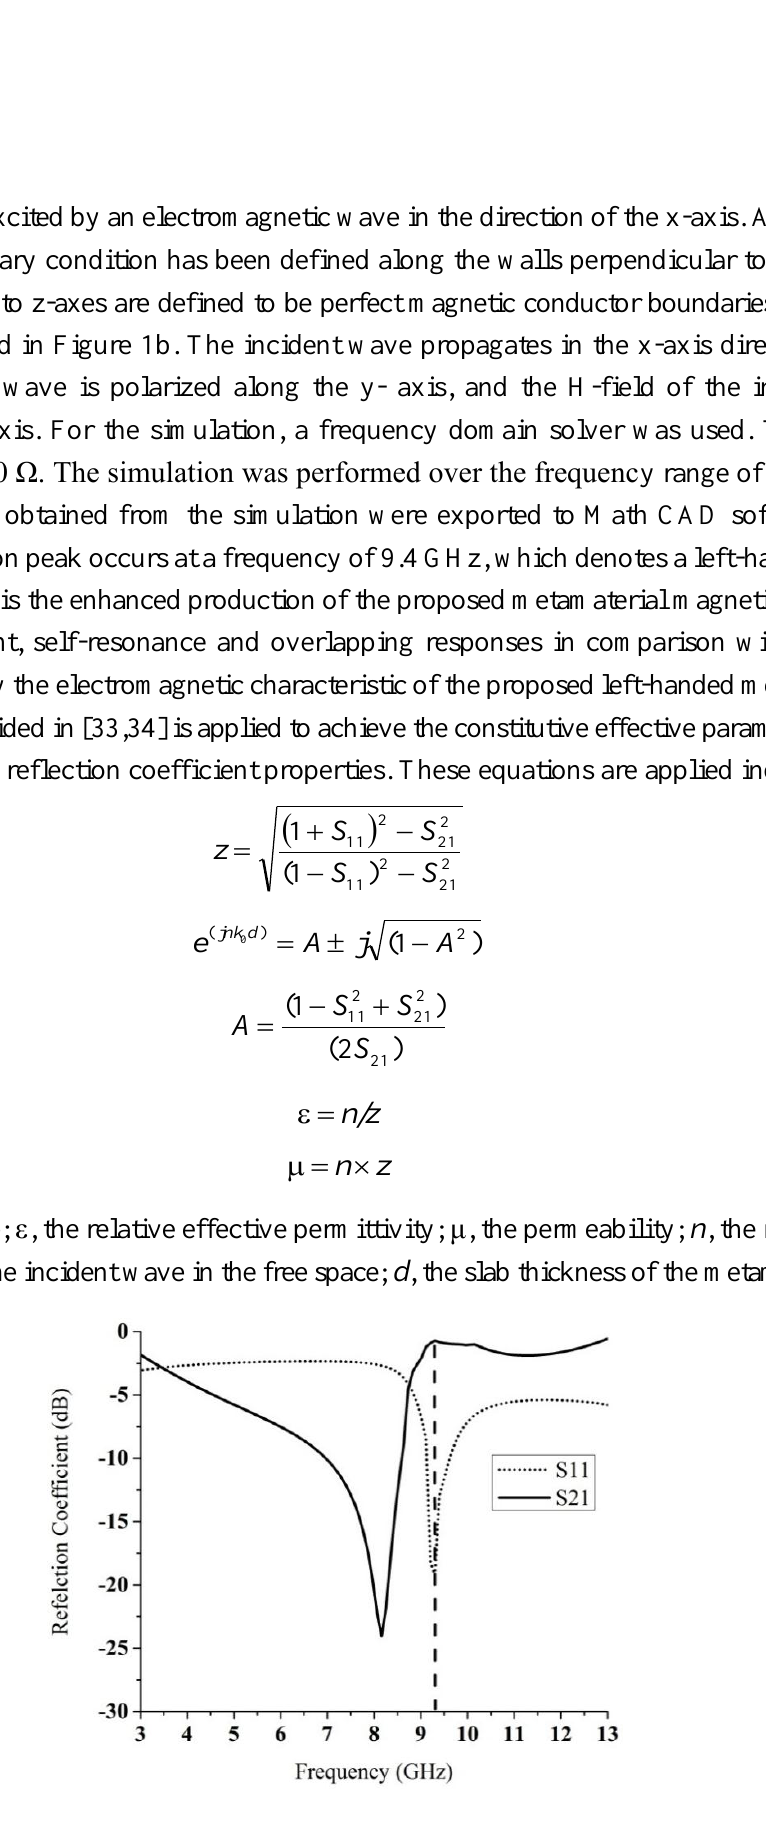
Figure 2. Simulation results of S-parameters for the unit cell plotted in Figure